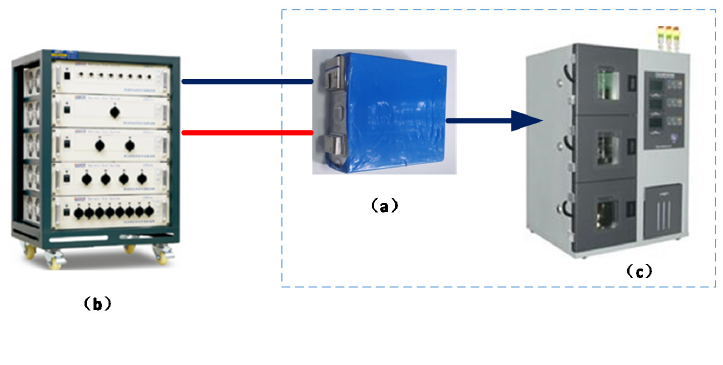
Figure 4. Appearance diagram of experimental equipment.